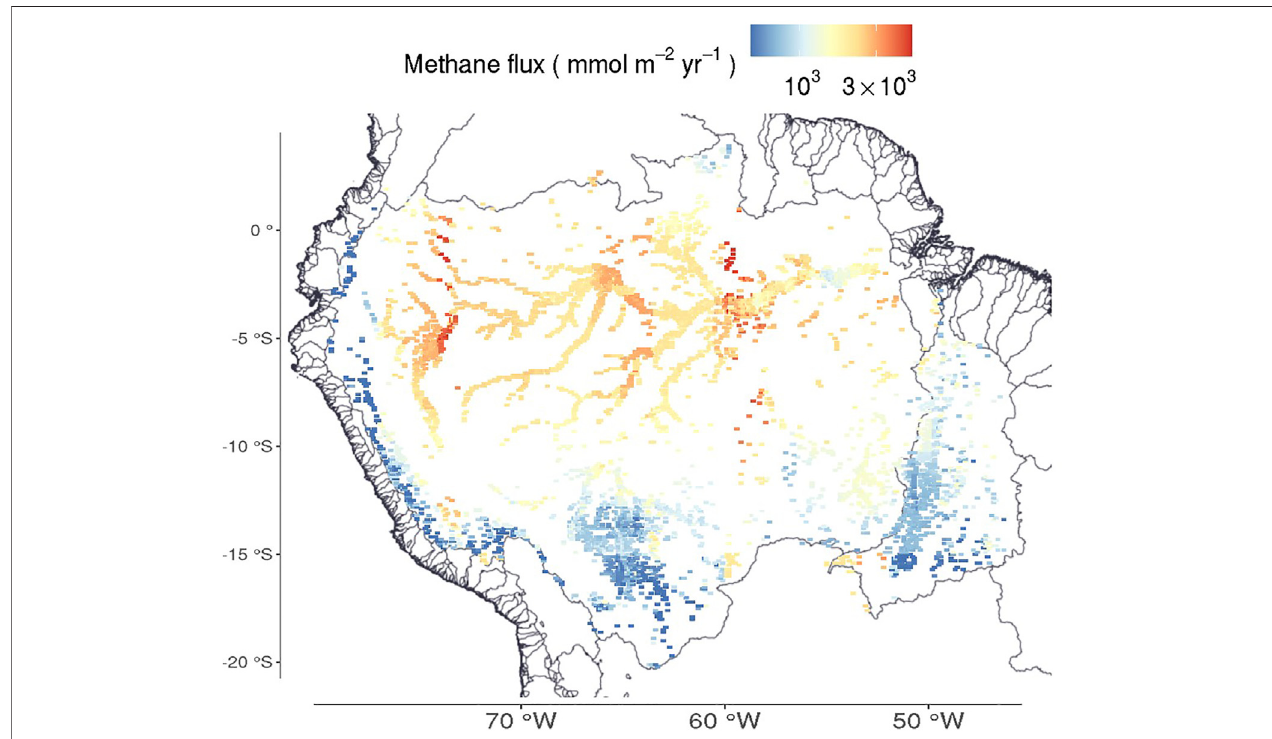
FIGURE6| Meanannualmethane fl uxesforonlylakes,expressed asmmolesofCH 4 m − 2 y − 1 ,weightedaveragedbylakeareawithin0.5 ° ×0.5 ° gridcellsfor2004 through 2006 as modeled by ALBM (Tan et al., 2015; Guo et al., 2020). Both the Amazon and Tocantins basins are